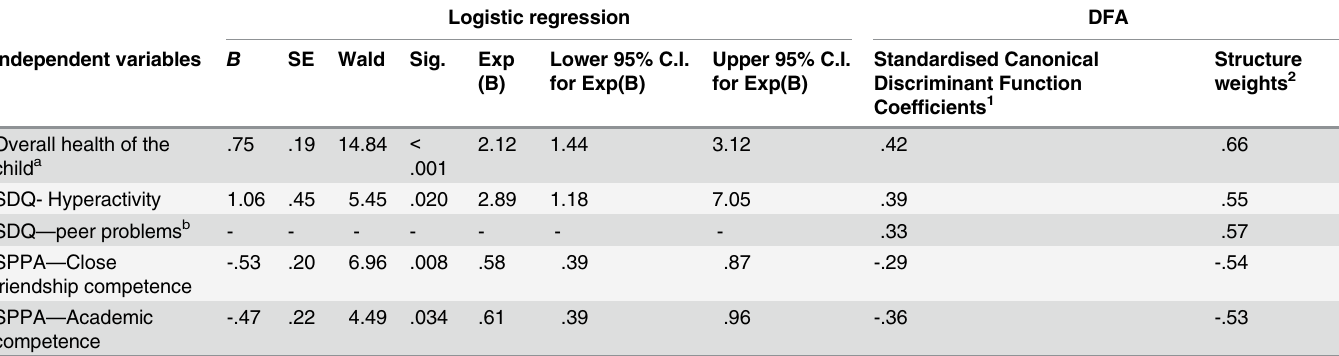
Table 4. Predictors, standardised, and unstandardised coefficients for the discriminant analysis model and logistic regression model. Logistic